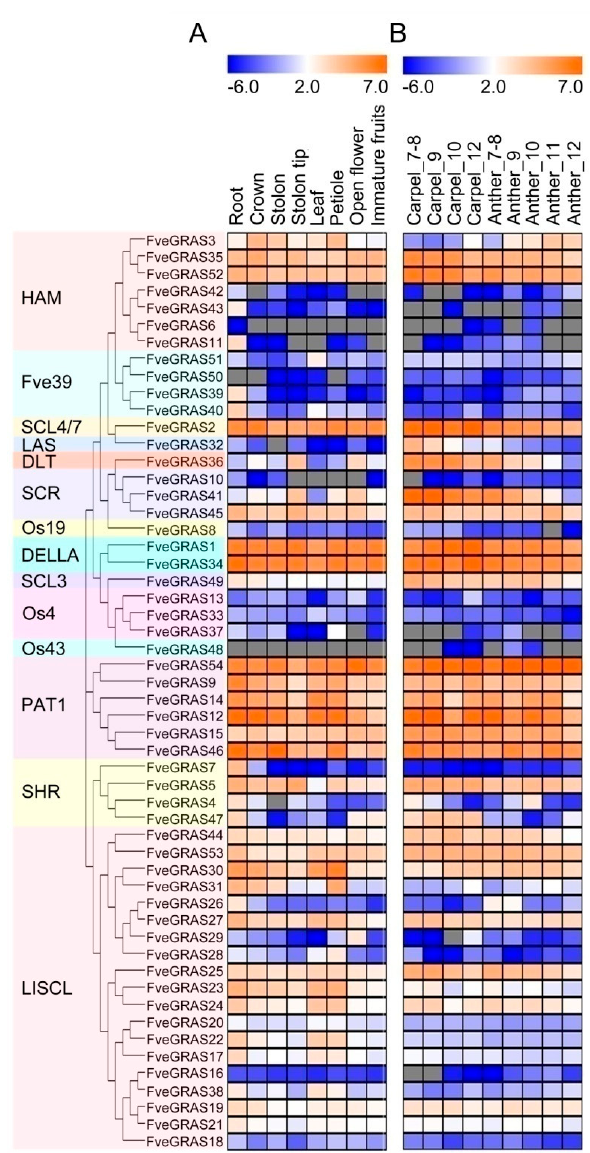
Figure 4. Expression pattern of GRAS genes in various organs of woodland strawberry. ( A ) Expression pattern of GRAS genes in the root, crown, stolon, stolon tip, leaf, petiole, open flower and immature fruit of woodland strawberry. Samples were collected in our lab, and then RNA-seq was performed. ( B ) Expression pattern of GRAS genes in the developing carpel and anther of woodland strawberry. The transcriptome data was downloaded from Li et al. (2019) [43]. Fragments per kilobase per million (FPKM) values in ( A ) and reads per kilobase per million (RPKM) values in ( B ) were in Supplementary Tables S5 and S6, and the heat map showed log2 level. Numbers after carpel and anther represent the developmental stages. The details of the stages were on the website (http: // bioinformatics.towson.edu / strawberry / newpage / Tissue_Description.aspx. Access date: 25 May